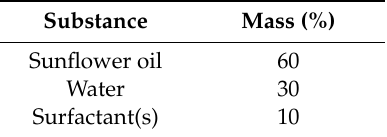
Table 1. Emulsion